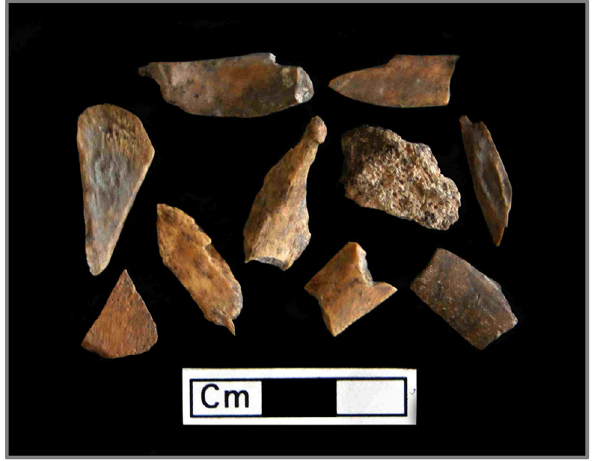
Figure 11: Digested bones ( from midden deposit, unit 12277, Space 437, TP Area, Level TP.Q, Çatalhöyük East ) . ( Photo by K. Paw ł owska )